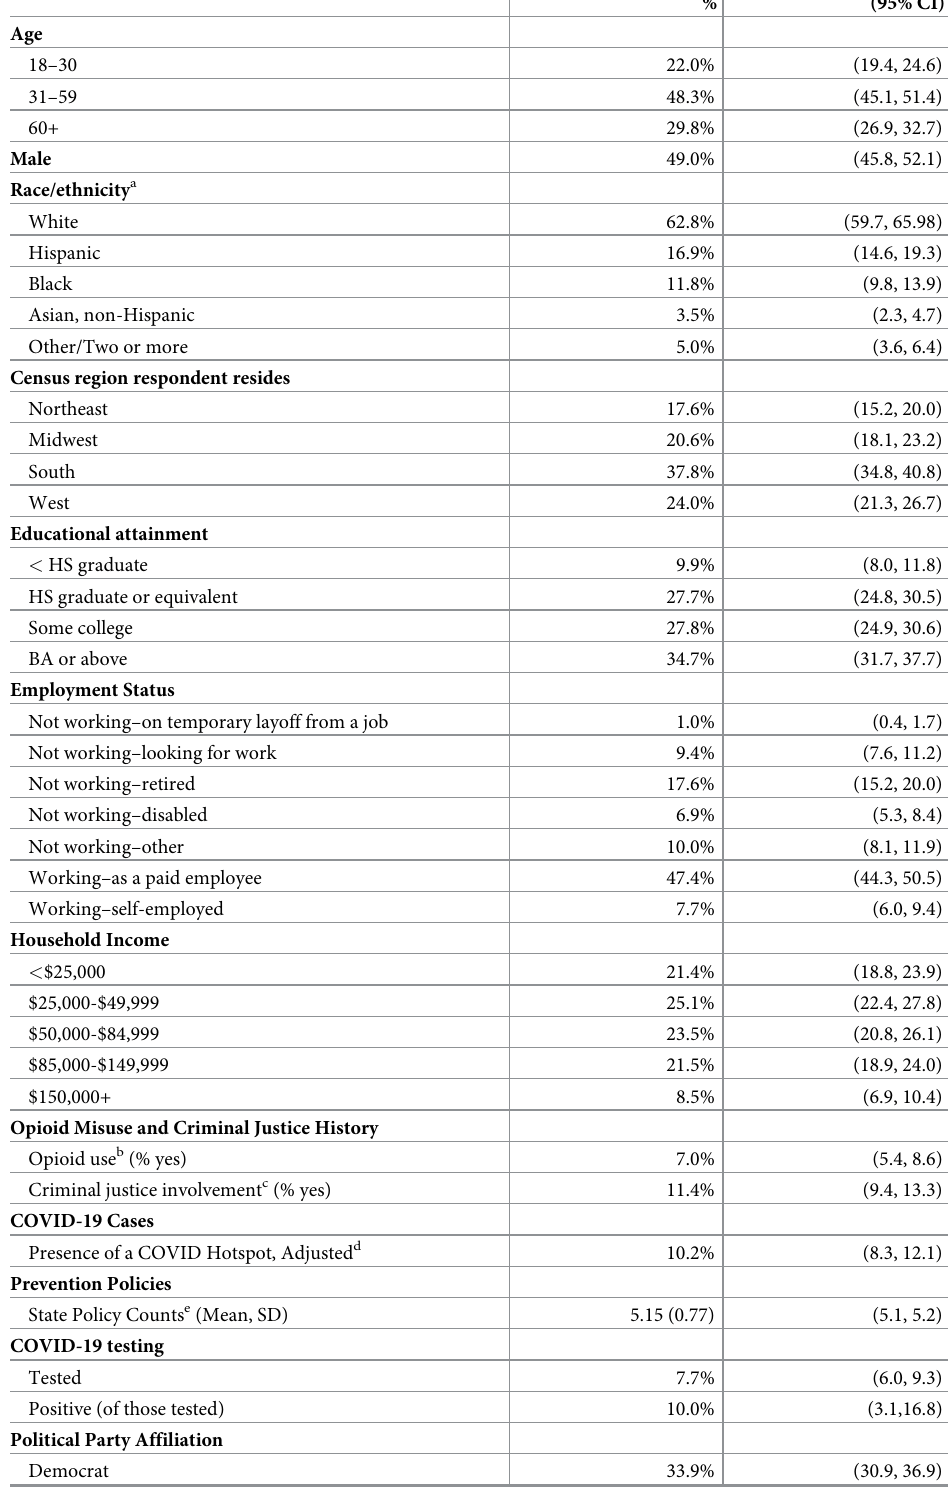
Table 1. Characteristics of adult respondents, April 30-May 4, 2020 (n =